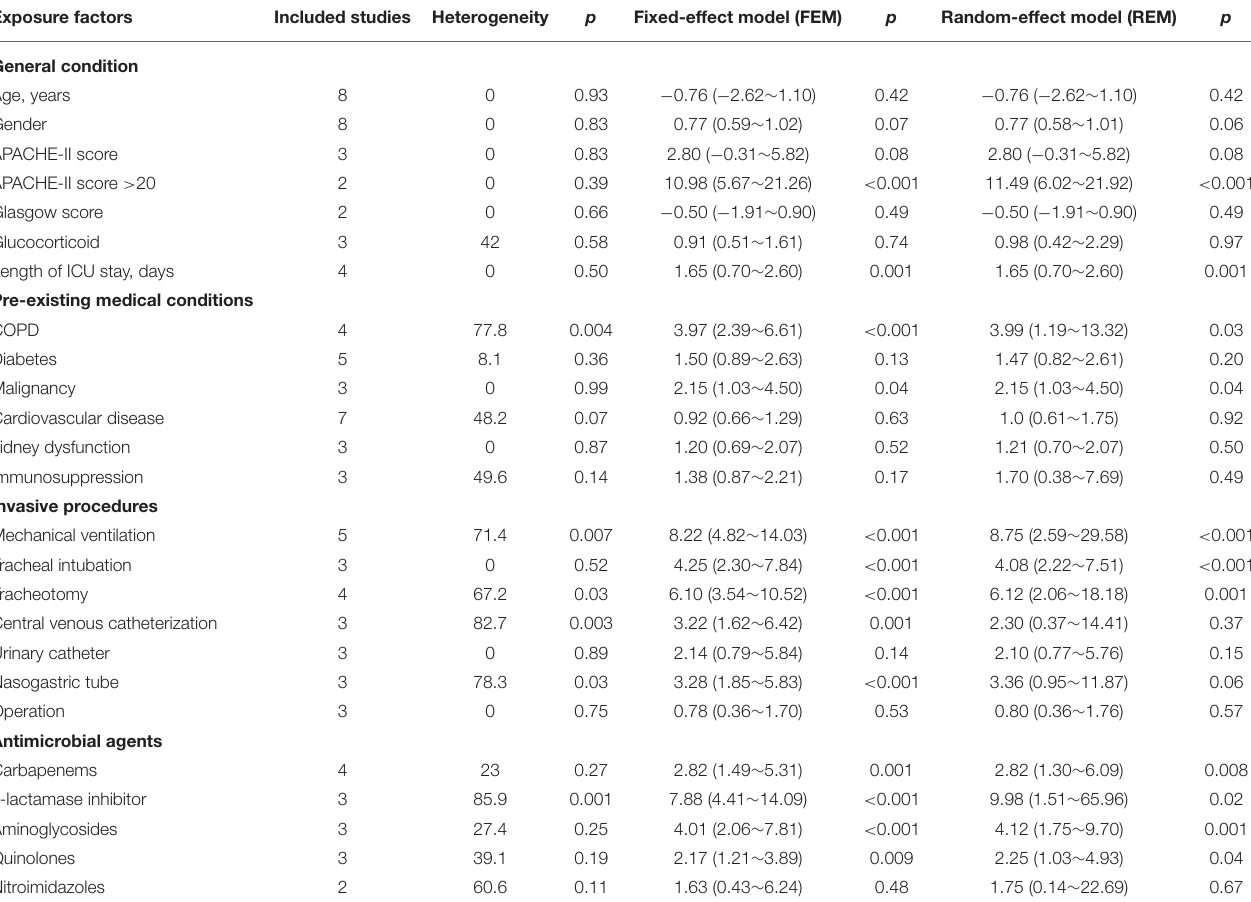
TABLE 3 | Meta-analysis results of risk factors for acquired Stenotrophomonas maltophilia in intensive care unit. Exposure